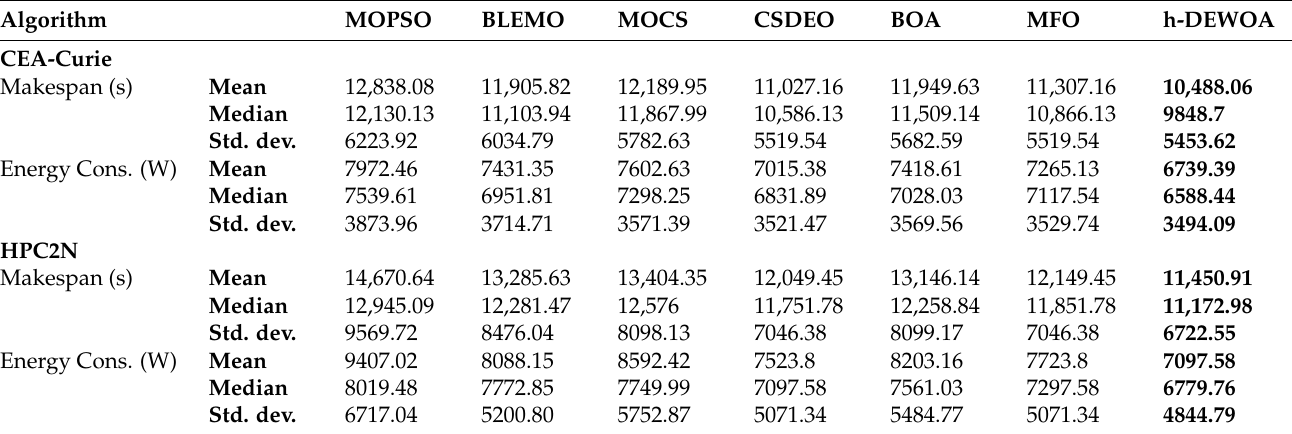
Table 18. Summary of overall results of scheduling algorithms for CEA-Curie and HPC2N workloads for the second set of experiments.